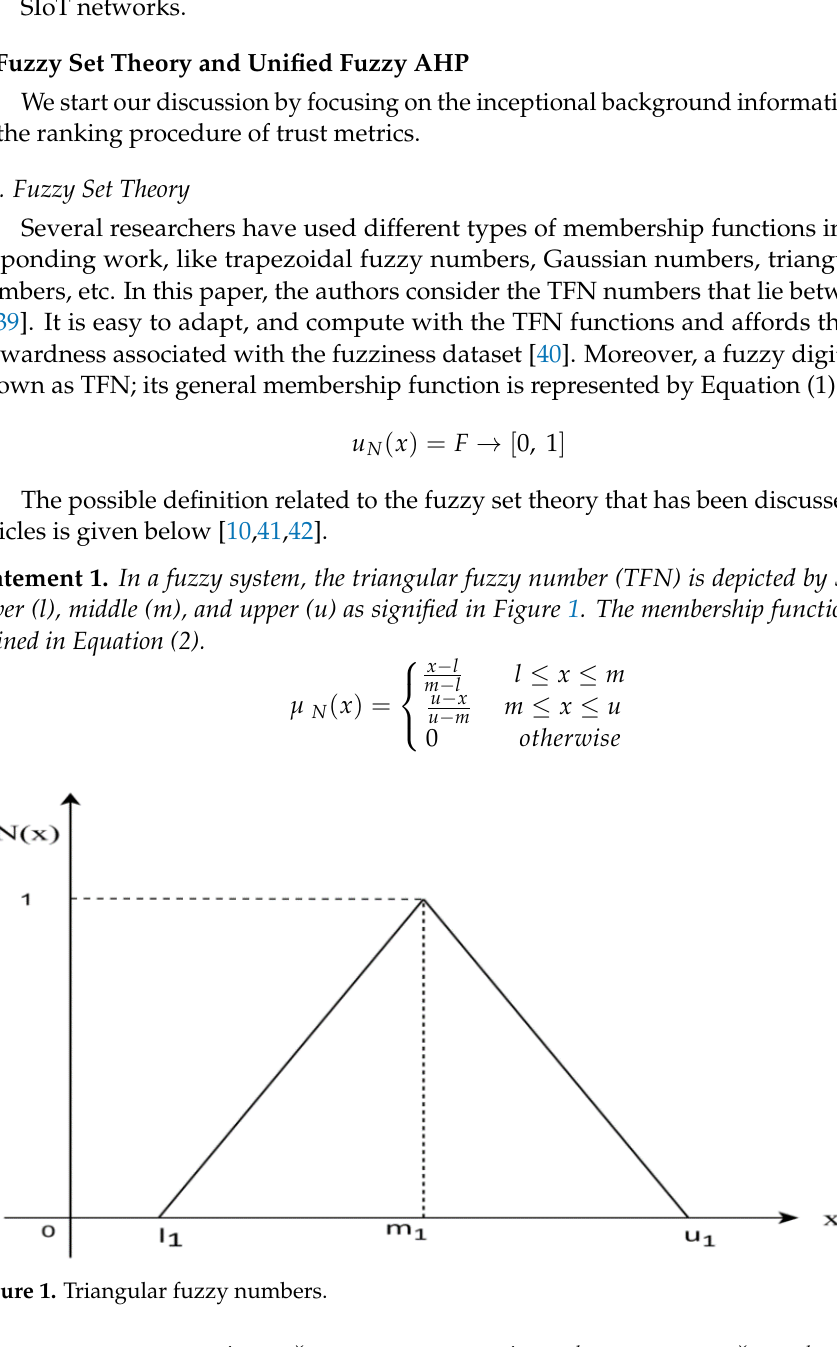
Figure 1. Triangular fuzzy